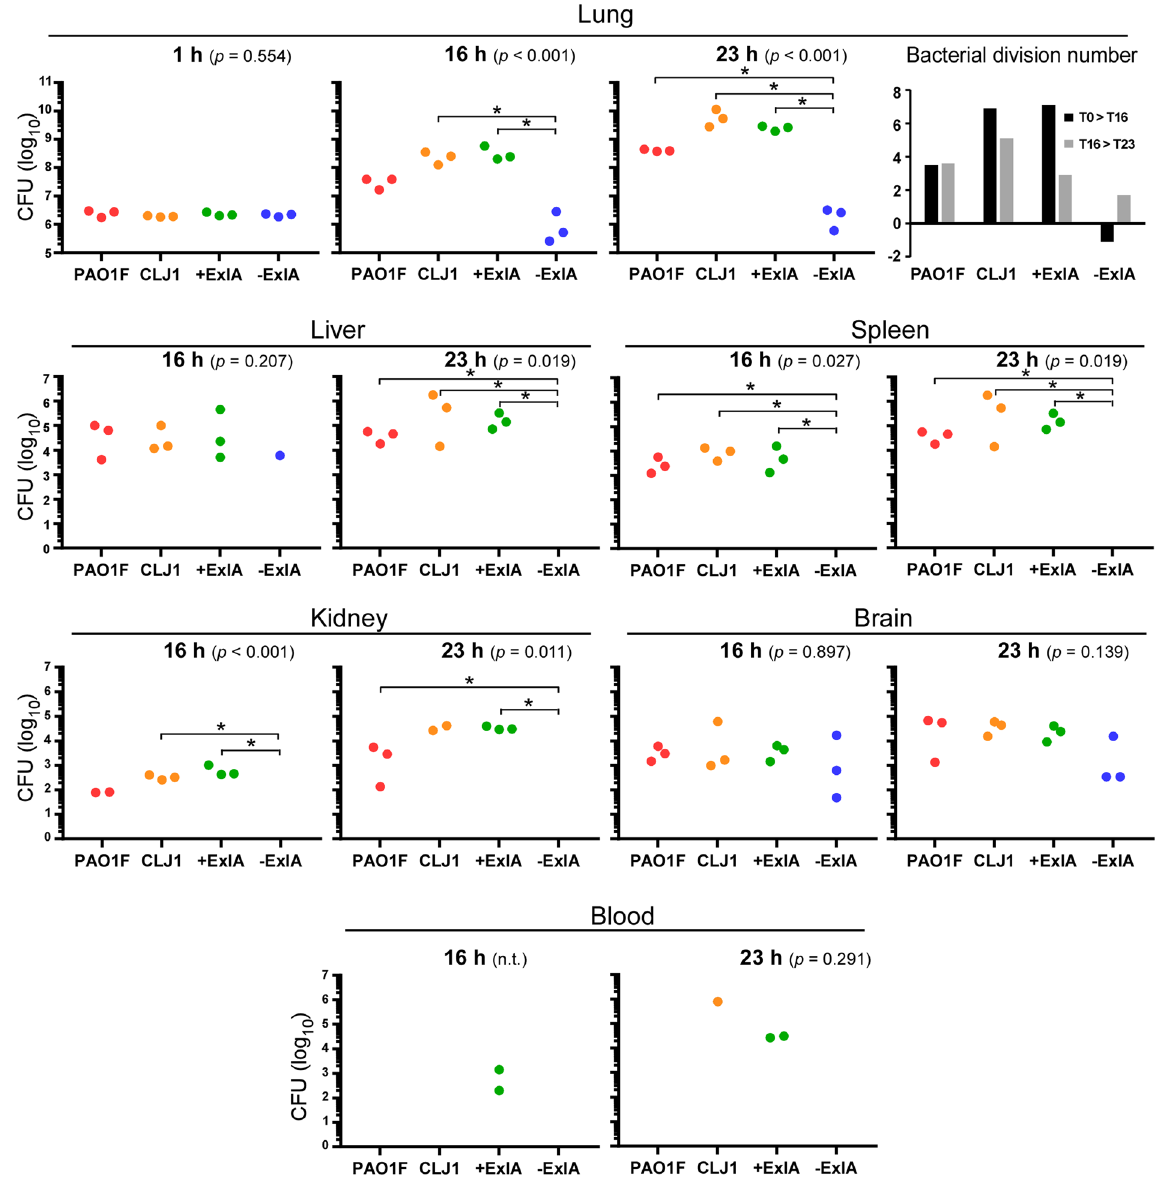
Figure 1. Pulmonary infection: bacterial load in the lung and dissemination in various mouse organs. Mouse lungs were infected with 2.5 × 10 6 bacterial suspensions of PAO1F, CLJ1, PAO1F Δ T3SS:: exlBA ( + ExlA), PAO1F Δ T3SS::empty vector ( − ExlA). Organs (lung, spleen, liver, kidney, brain and blood) were isolated at 1, 16 and 23 h.p.i., as indicated, were homogenized and serial dilutions of the homogenates were plated onto agar plates to determine the CFU per organ. Of note, no bacteria were found outside of the lung at 1 h.p.i. Data are represented by solid circles on logarithmic scales. Three mice were used per strain and per time point. Statistical differences were calculated using Kruskal-Wallis’s test and probabilities are indicated between parenthesis in each condition; n.t., not testable; pairwise comparisons were established with Holm-Sidak’s post-hoc test: * p < 0.05. In the lungs, the bacterial division rates between 1 and 16 h.p.i. (T1 > T16), and between 16 and 23 h.p.i. (T16 > T23), were calculated for the different strains and plotted (upper